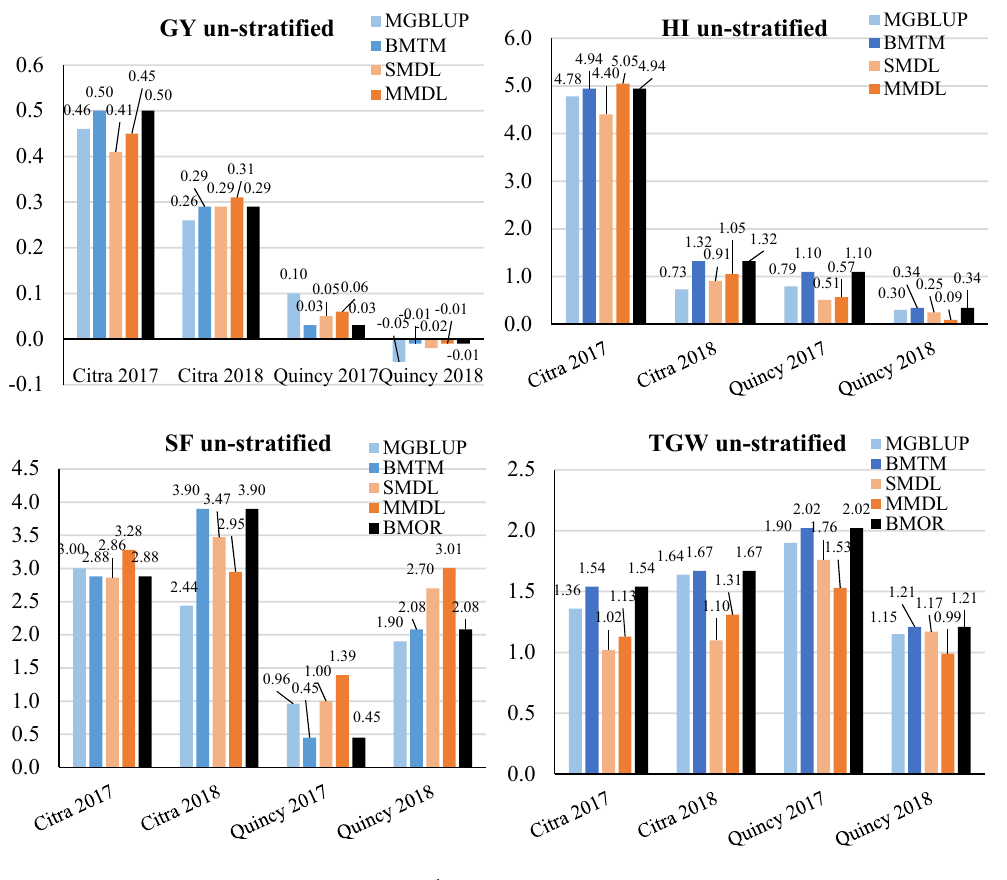
Figure 7. Response to selection for GY (t ha − 1 ), HI (%), SF (grains / g cha ff weight), and TGW (g) without population stratified. GY, grain yield; HI, harvest index; SF, spike fertility; TGW, thousand grain weight. Response to selection for each environment was presented and labeled for each trait. Statistical models were colored in light blue and blue, while DL models were colored in light orange and orange. The BMOR model was colored in black.